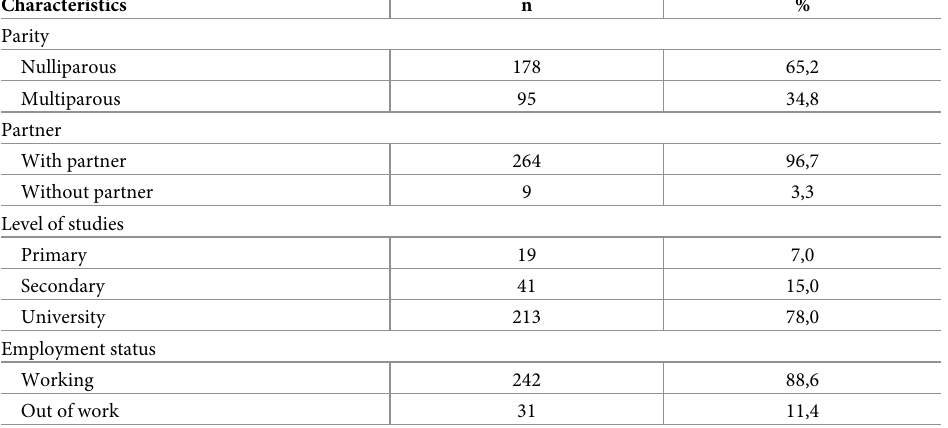
Table 4. Goodness-of-fit indices for the confirmatory model W-DEQ-A-Sp.